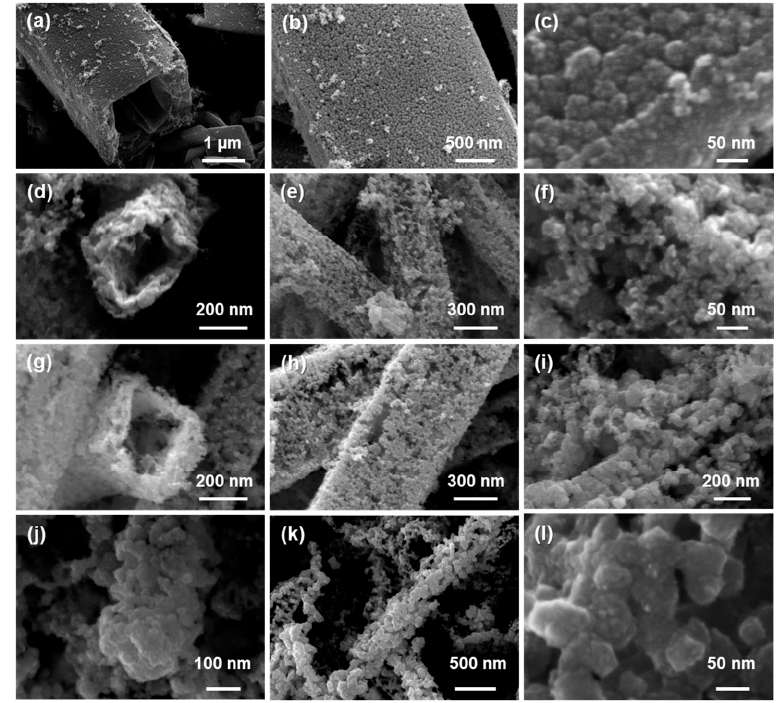
Figure 3. Scanning electron microscope images of platinum-copper macrotubes from 0.1 M DMAB